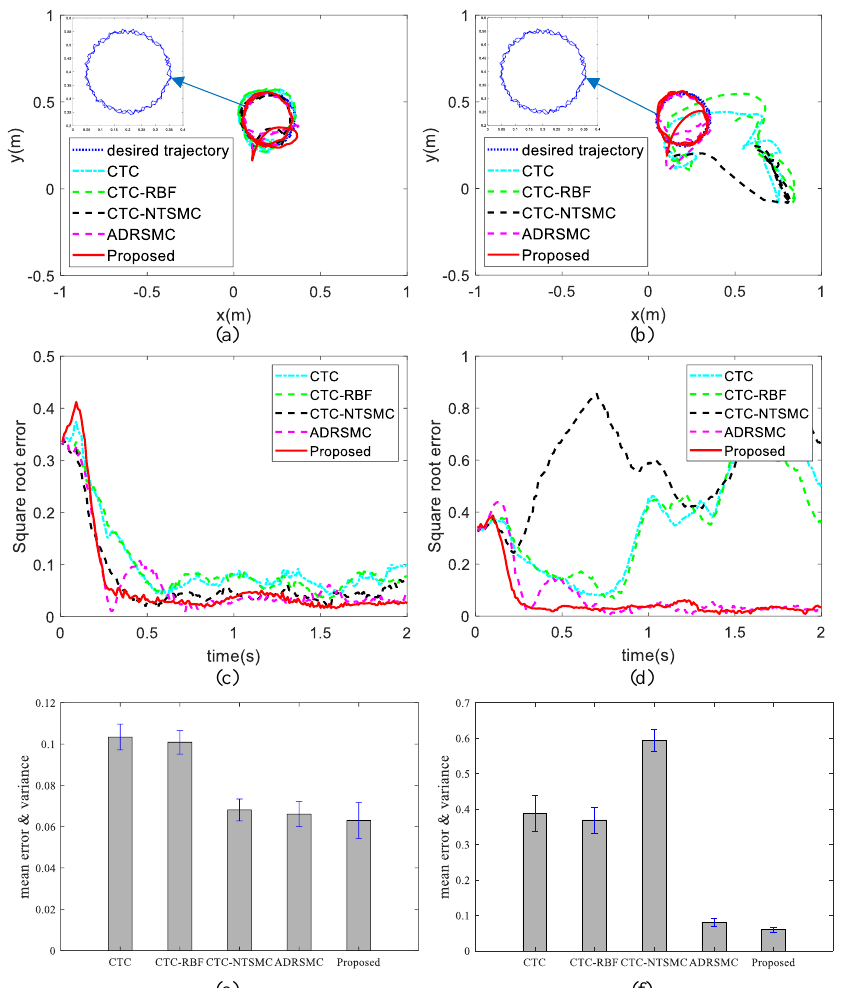
Figure 8. Comparison results of the non-uniform trajectory tracking. ( a ) end motion trajectories without the addition of joint measurement noises, ( b ) end motion trajectories with the addition of joint measurement noises, ( c ) square root errors without the addition of joint measurement noises, ( d ) square root errors with the addition of joint measurement noises, ( e ) mean errors and variances without the addition of joint measurement noises, ( f ) mean errors and variances with the addition of joint measurement